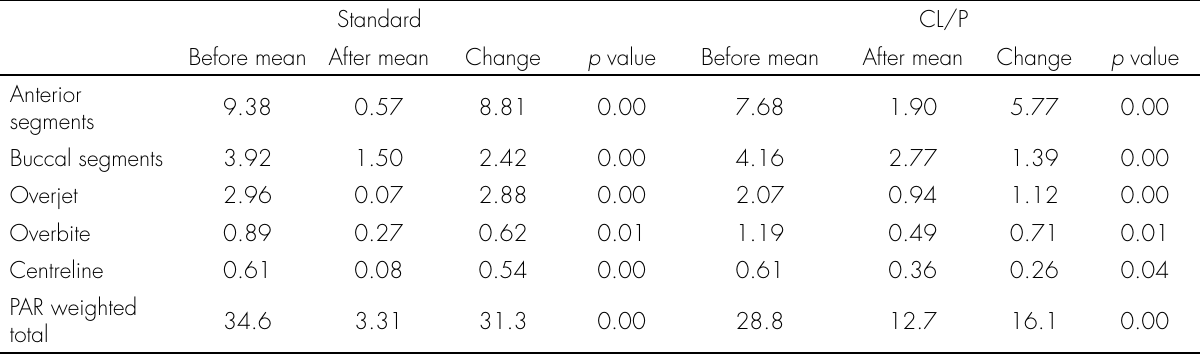
Table IV. The components and weighted total score of the Peer Assessment Rating (PAR) index before and after treatment (brackets contain standard deviations unless otherwise